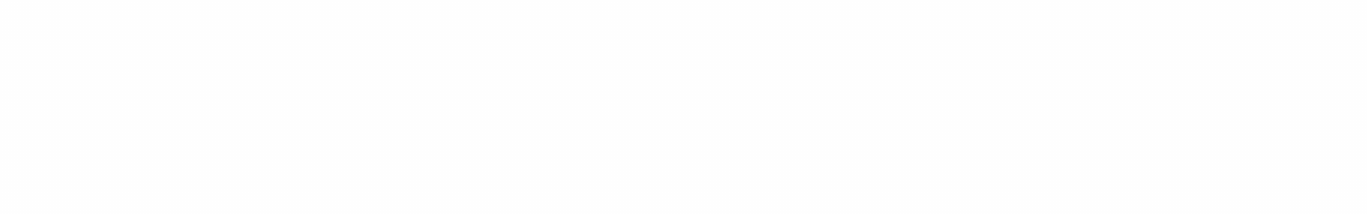
Fig. 3: Reaching success (mean and SE of percentage scores) displayed by control and pyramidal tract lesion rats when reaching in the tray task and the single pellet task with the preferred paw (NP, the contralateral forepaw that was used following forced training) or the paw ipsilateral (I) or the paw contralateral to the lesion (C). Note: No differences in success were displayed by control or partial lesion rats when using either paw. Performance using the ipsilateral-to-lesion paw by the complete lesion pyramidal tract group did not differ from control performance. Performance using the paw contra-lateral (C)-to-lesion by the contralateral group was significantly (*p < 0.05) impaired in both